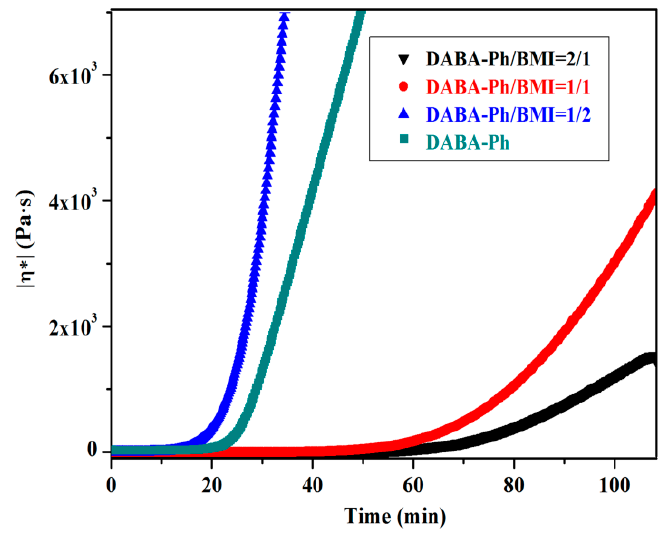
Figure 3. Gelation time at 180 °C for DABA-Ph/BMI pre-polymers with various content of BMI.